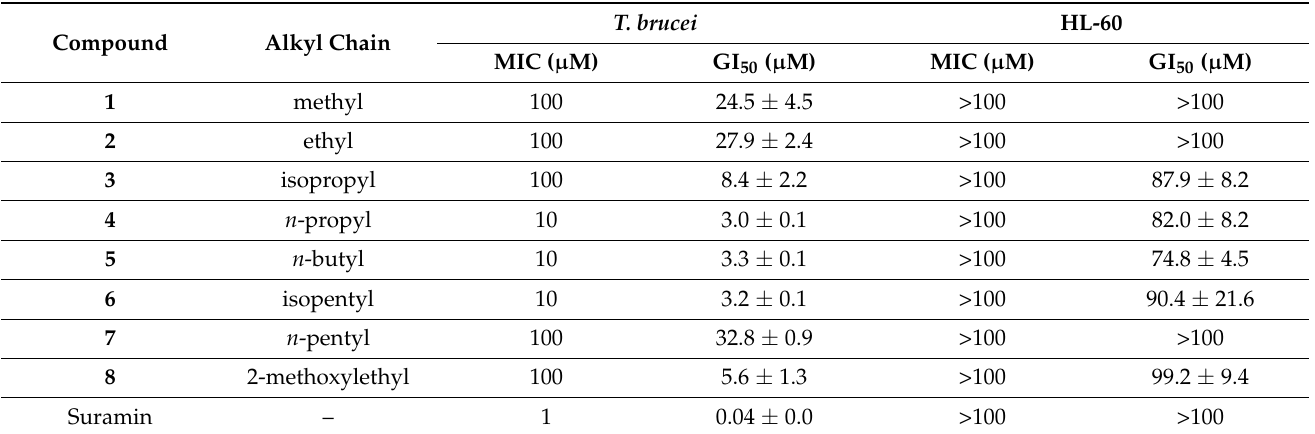
Table 1. In vitro trypanocidal activity of gallic acid alkyl esters against bloodstream forms of T. brucei and human myeloid HL-60 cells.